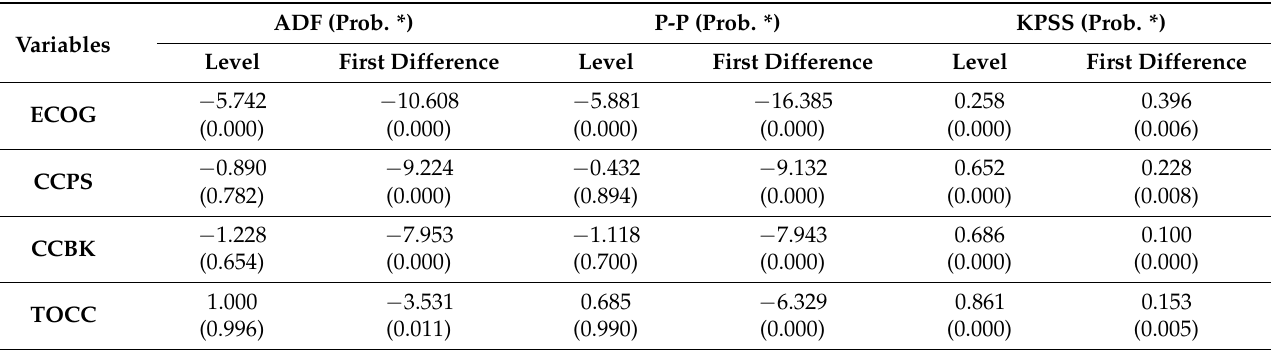
Table 2. Unit root technique outcomes.